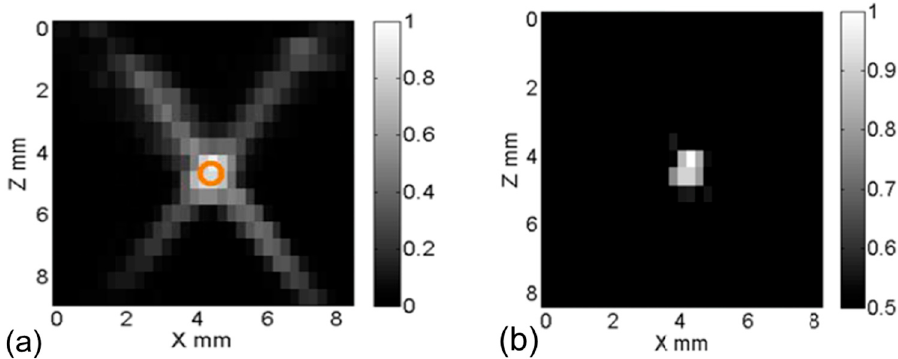
Figure 1. Ultrasound switchable fluorescence images obtained using dual-HIFU for a micro-silicone tube filled with ADP(OH) 2 based contrast agent; ( a ) with no threshold applied; and ( b ) with 50% and above pass through applied.